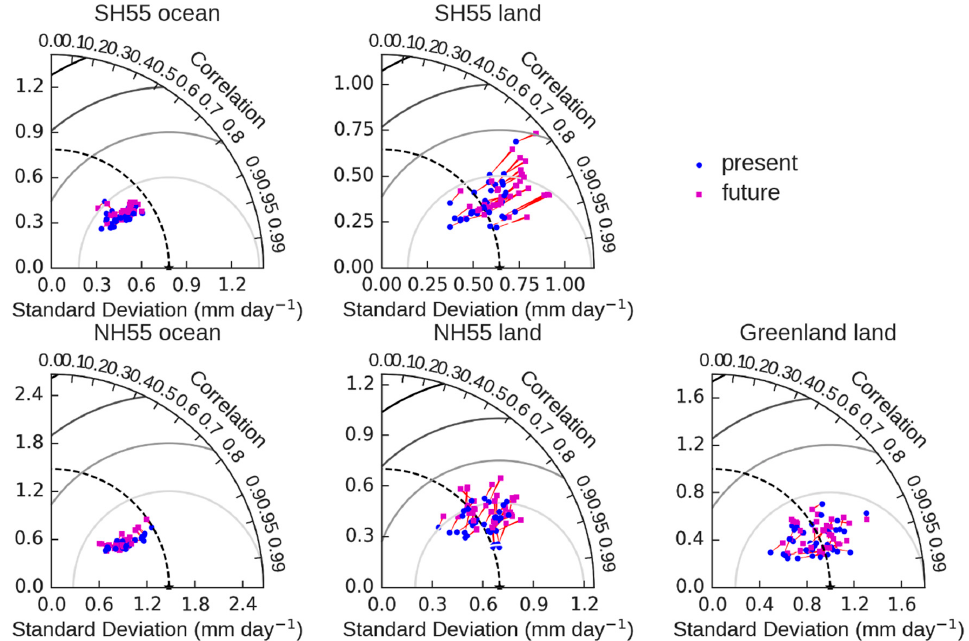
Figure 8. Taylor Diagrams of present and future precipitation for each of the studied high-latitude regions. The reference is shown as a star on the bottom axis in each case, and is CloudSat for SH55 land, SH55 ocean and NH55 ocean. For the others it is ECMWF ERA-I. CMIP5 1976–2005 averages are in blue and 2070–2099 in magenta, with red lines linking each simulation’s change.